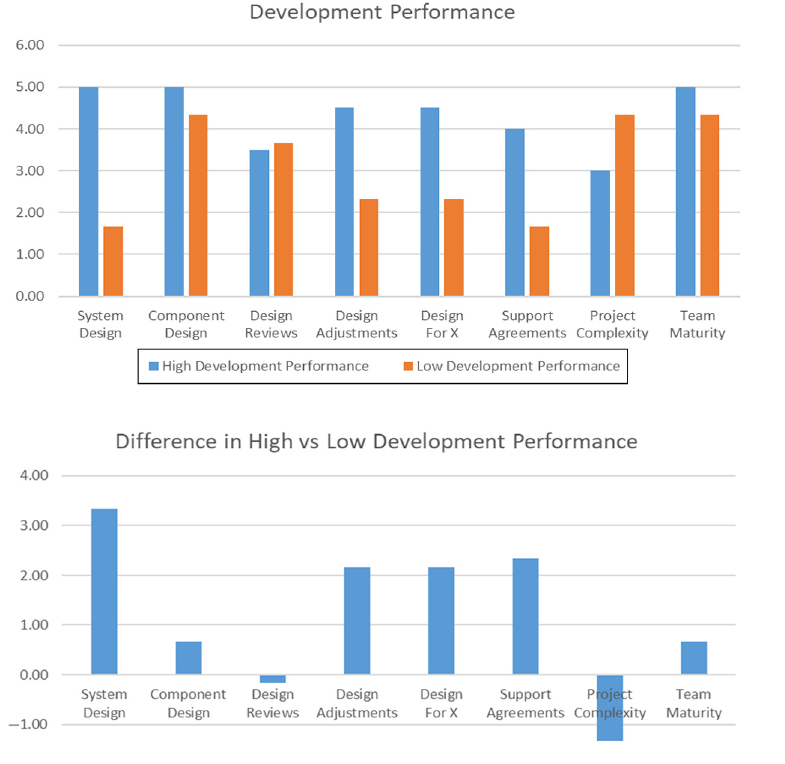
Figure 4. Impact on development